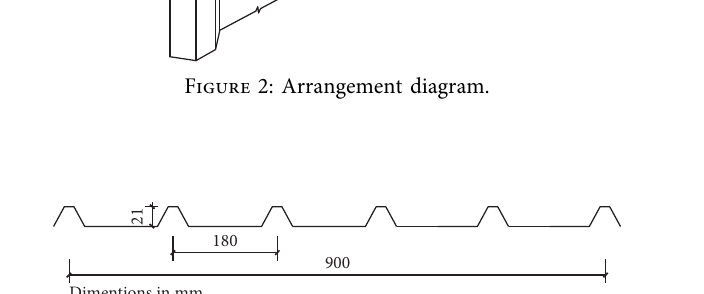
Figure 3: Cross section dimensions of corrugated steel